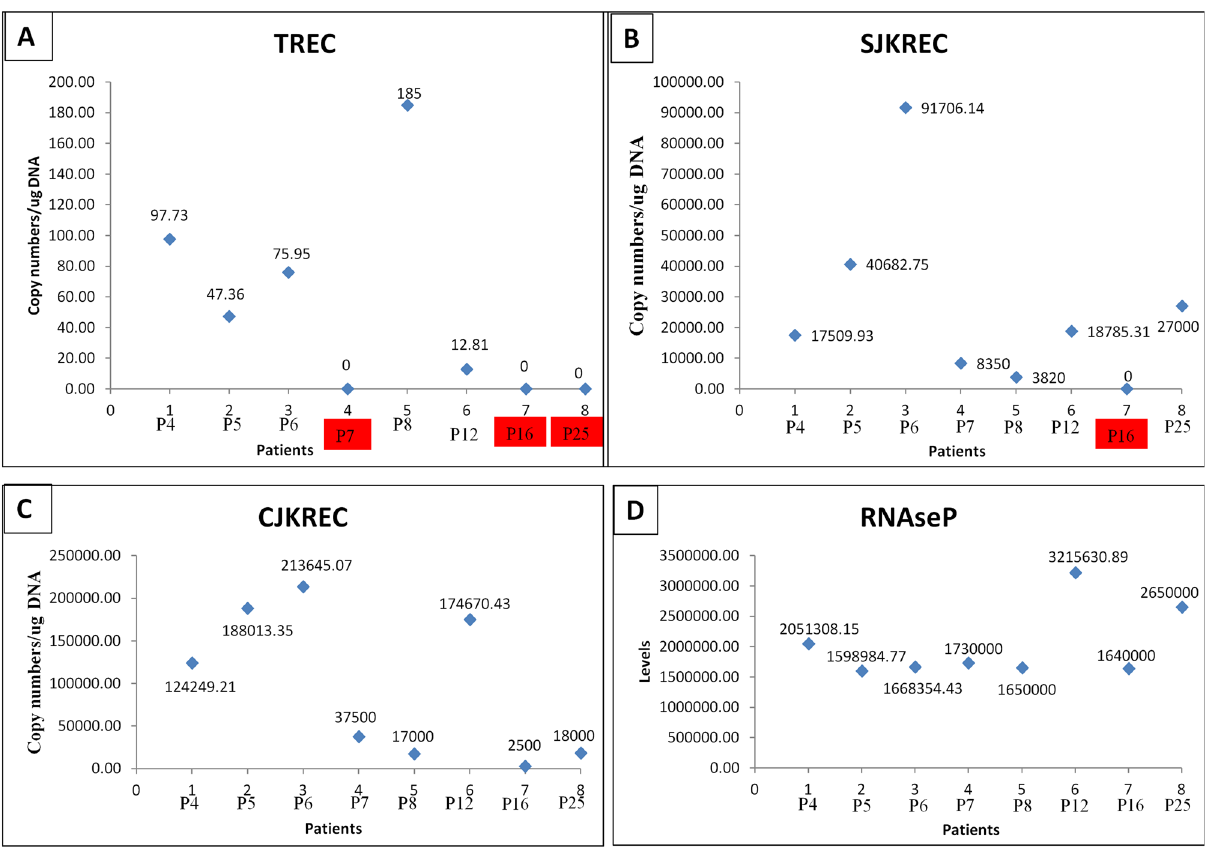
Figure 3. Scatter plot representing the copy number values of ( A ) TREC, ( B ) sjKRECs, ( C ) cjKRECs and ( D ) RNAseP as internal control. P represents number of case along with the values. X axis: Serial numbers of cases.